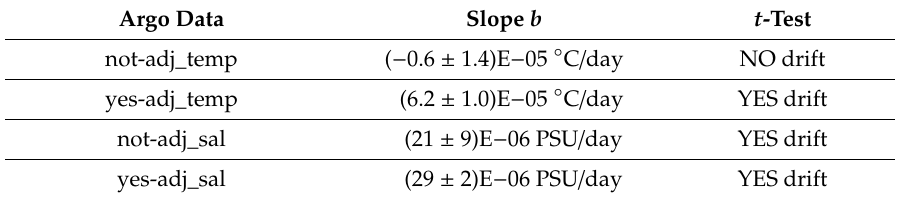
Table 8. Statistical estimates of Argo drifts on temperature and salinity